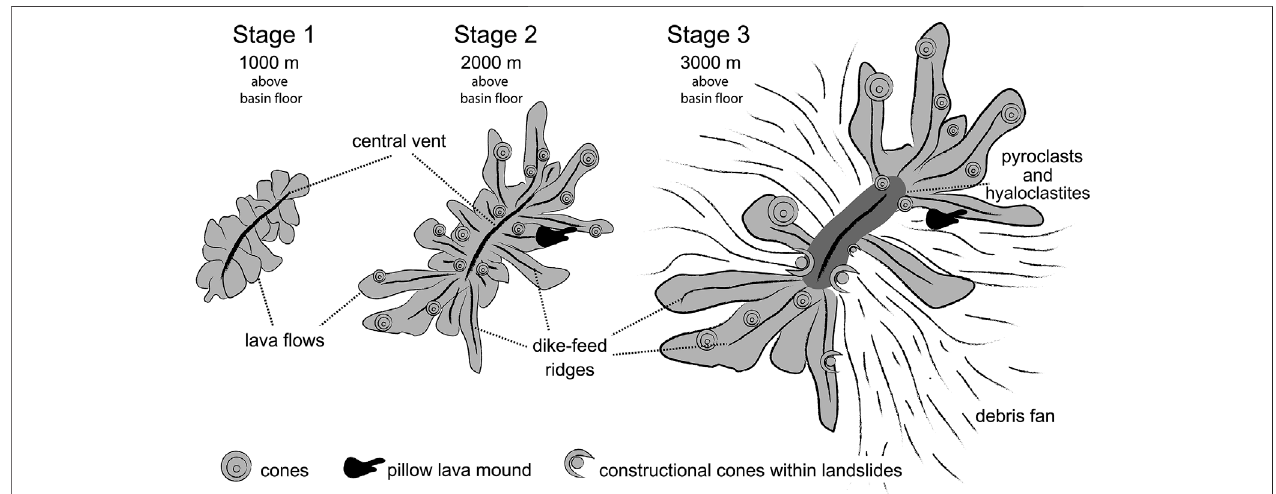
FIGURE 11 | Interpretive Cartoon illustrating three volcanic growth stages of Vesteris Seamount.